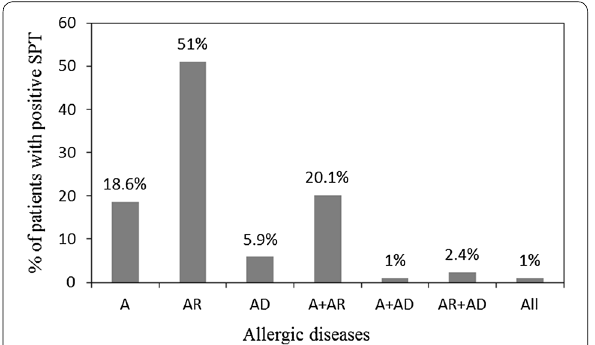
Fig. 4 The distribution of allergic diseases among adult patients who attended the allergy clinics in Qatar during the study period (n